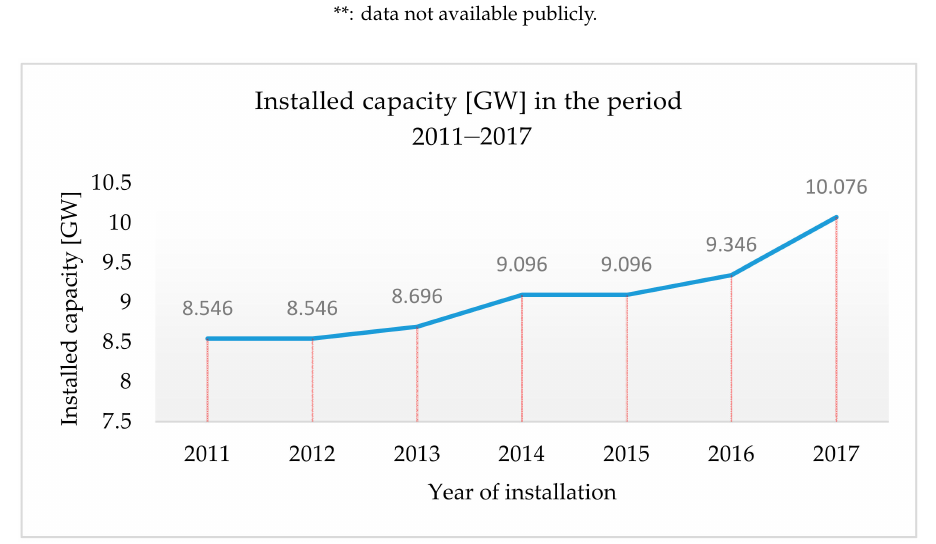
Figure 6. Installed capacity in the period